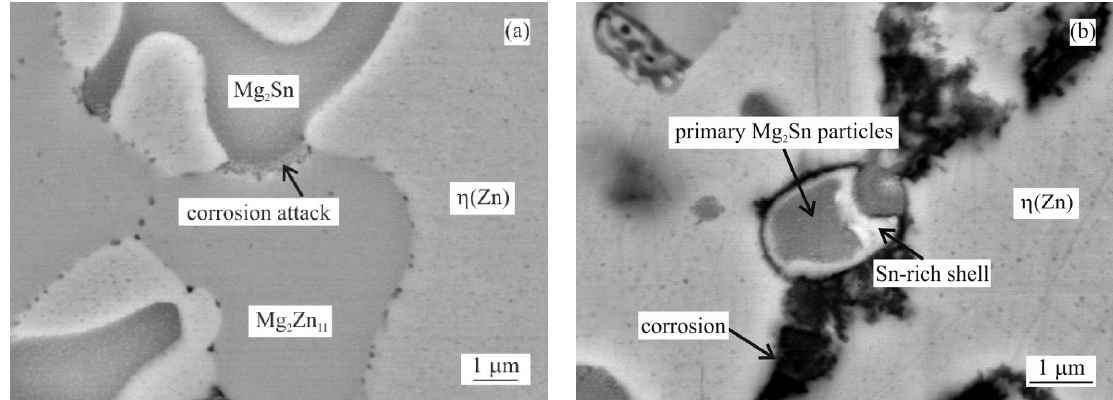
Figure 14. Behaviour of Mg 2 Sn intermetallic phase during corrosion (MZ + 2.0Sn, annealed): ( a ) Influence of Mg 2 Sn on initial stage of corrosion of Mg 2 Zn 11 intermetallic particle; ( b ) dealloying of Mg 2 Sn particle.